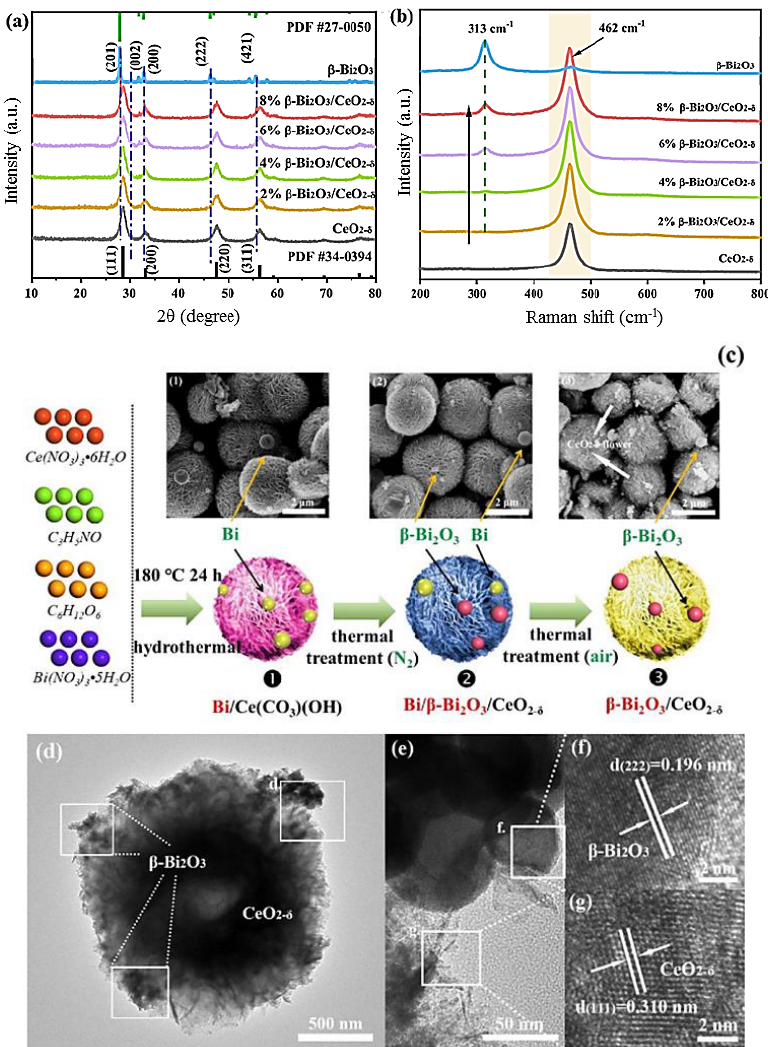
Figure 12. X-ray diffraction patterns ( a ) and Raman spectra ( b ) of CeO 2- δ , β -Bi 2 O 3 , and β -Bi 2 O 3 /CeO 2- δ samples. ( c ) Scanning electron microscopy images and schematic representation of the formation process of 4% β -Bi 2 O 3 /CeO 2- δ . ( d , e ) Transmission electron microscopy (TEM) and high-resolution TEM showing the various species in sample ( f , g ) images of 4% β -Bi 2 O 3 /CeO 2- δ . Reproduced with permission from [150]. Copyright 2021 Elsevier.